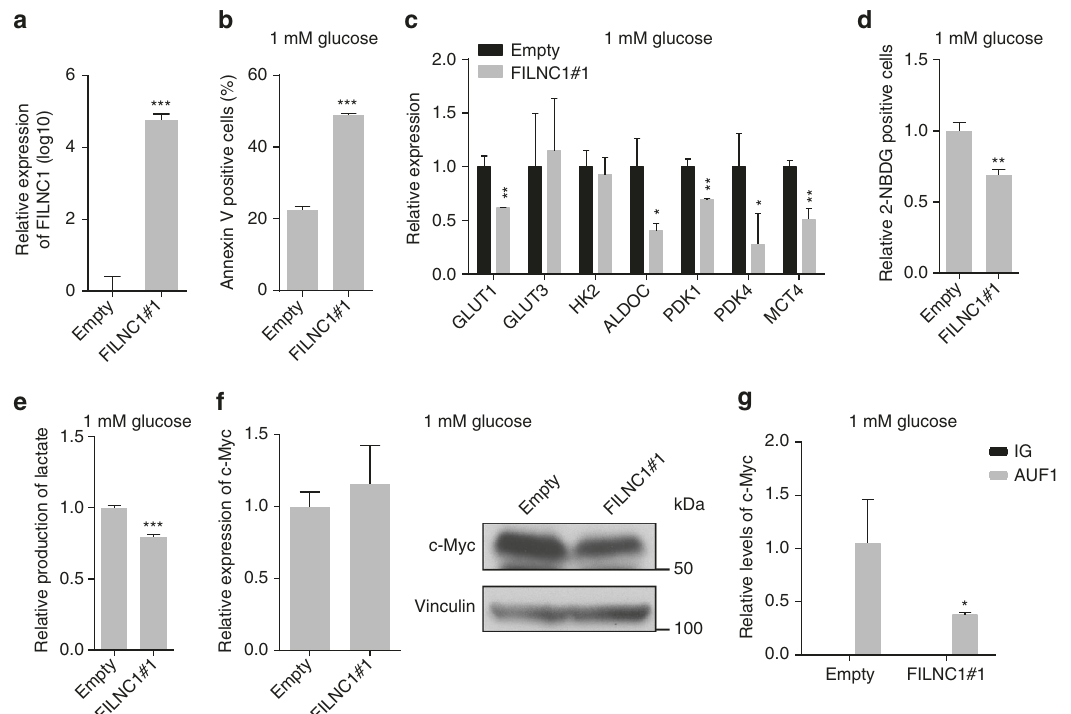
Fig. 6 The effect of FILNC1 overexpression on energy metabolism and c-Myc regulation. a Bar graph shows the relative expression changes of FILNC1 by real-time PCR in 769 P cells infected with either empty or FILNC1 overexpression vectors. b – e 769 P cells infected with either empty or FILNC1 overexpression vectors were cultured in 1 mM glucose-containing medium for 48 h, and then subjected to various analyses to measure the percentages of cell death (Annexin V-positive cells) ( b ), the expression levels of genes involved in glucose metabolism by real-time PCR ( c ), glucose uptake ( d ) and lactate production ( e ). f Real-time PCR and western blotting analyses to measure c-Myc mRNA and protein levels in 769 P cells infected with empty or FILNC1 overexpression vectors which had been cultured in 1 mM glucose-containing medium for 24 h. g Whole-cell lysates were collected from 769 P cells infected with either empty or FILNC1 overexpression vectors that had been cultured in 1 mM glucose-containing medium for 24 h, and immunoprecipitated with AUF1 antibody or IgG. The levels of c-Myc mRNA in the precipitates were measured by real-time PCR and normalized using input RNA. Values represent mean ± s.d. from three independent experiments, two-tailed Student ’ s t -test. * P < 0.05; ** P < 0.01; *** P <